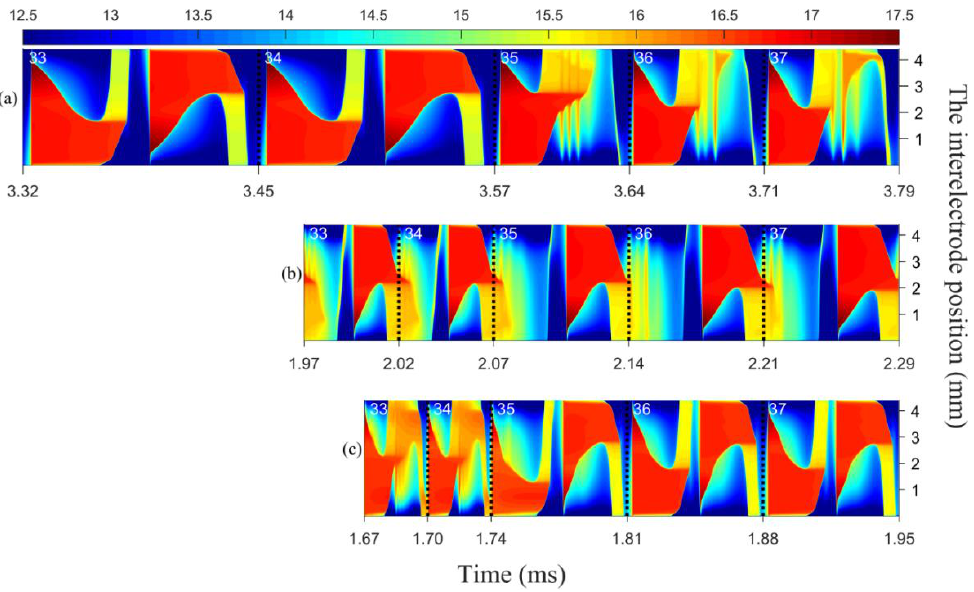
Figure 7. Spatiotemporal distribution of log 10 ( n e ) during the 33, 34, 35, 36 and 37 applied voltage cycle when f c is set to be ( a ) 8 kHz, ( b ) 20 kHz, ( c )30 kHz. The black dashed lines divide off different applied voltage cycles.